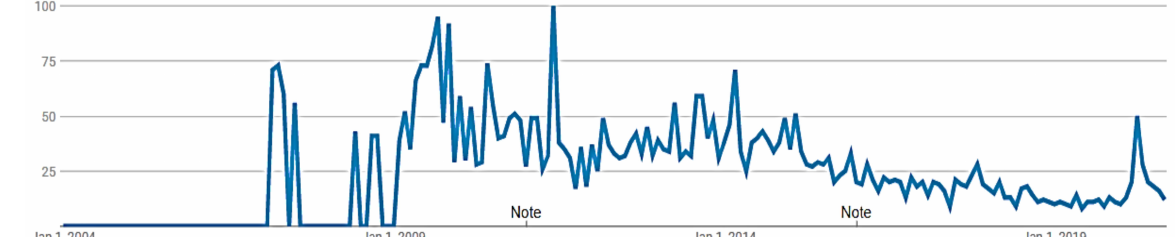
Figure 6. Google trends of “crowdsourcing” based on searches in